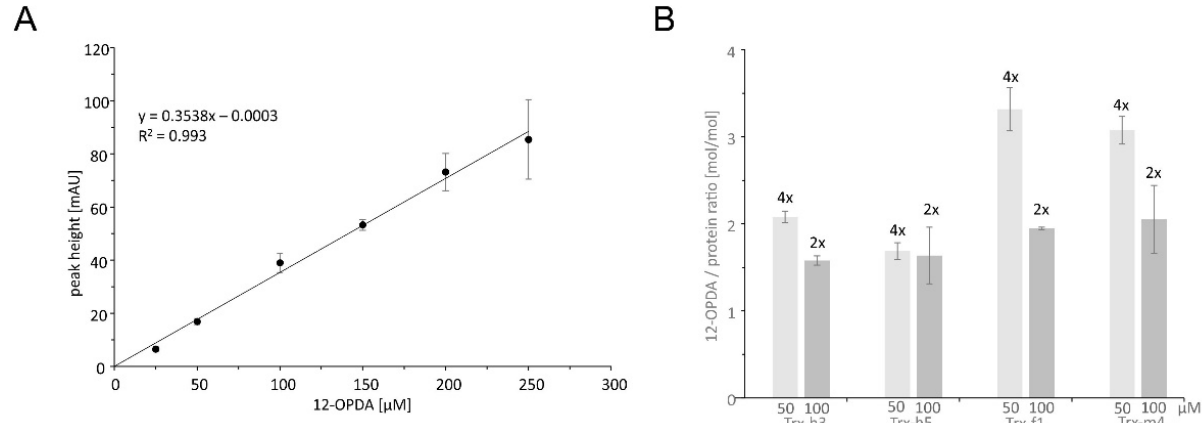
Figure 3 . Quantification of OPDA residues bound to TRX-f1, -m4, -h3 and -h5 by HPLC analysis. In total, 200 µM of 12-OPDA was incubated with either 50 or 100 µM of recombinant TRX-h3, TRX-h5, TRX-f1 and TRX-m4 or an equivalent amount of phosphate buffer. Proteins were reduced and desalted prior to the incubation. After 2 h, the amount of free unbound OPDA was determined by reverse phase HPLC. The determined remaining free OPDA was then subtracted from the total amount used for incubation with protein to obtain the amount of OPDA bound to the protein. This value was further divided by the protein concentration to obtain the molar OPDA/protein ratio. ( A ) Different OPDA concentrations were used to generate a standard curve based on peak height [mAU] at the retention time of 14.200 ± 0.014 min. Data are means ± SD of n ≥ 3. ( B ) Ratio of OPDA bound to recombinant TRX-f1, TRX-m4, TRX-h3 and TRX-h5 with molar excess of OPDA indicated above each bar. The change in free OPDA concentration was calculated using the standard curve shown in ( A ). Data are means ± SD of n ≥ 3.